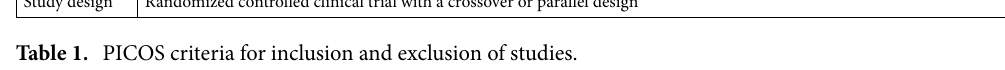
Table 1. PICOS criteria for inclusion and exclusion of